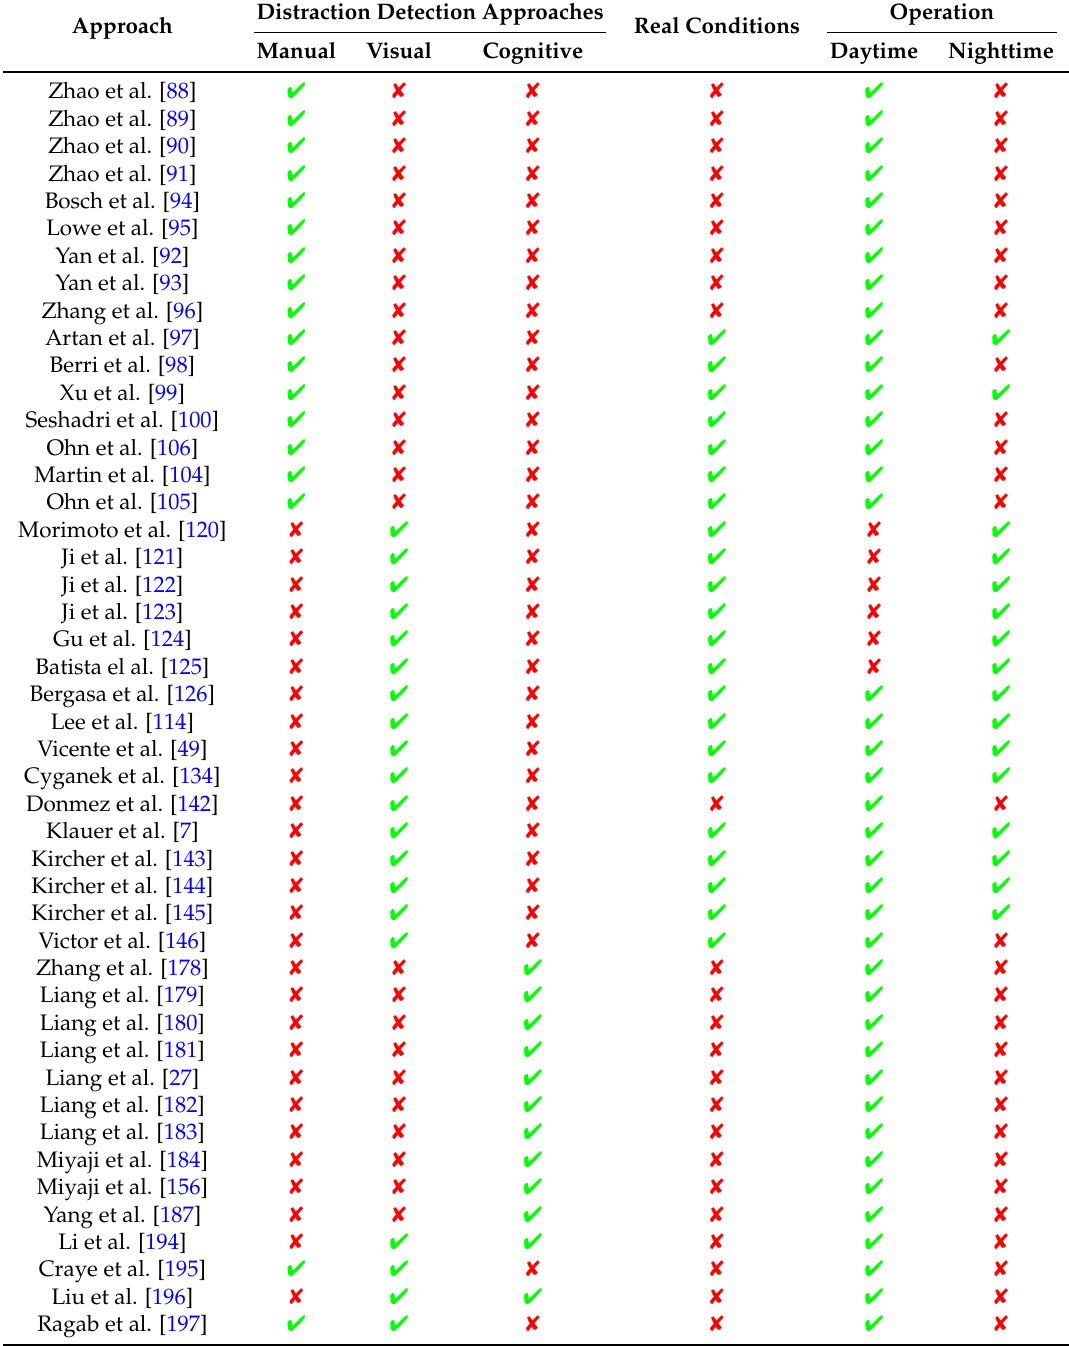
Table 8. Summary of visual-based approaches to detect different types of driver